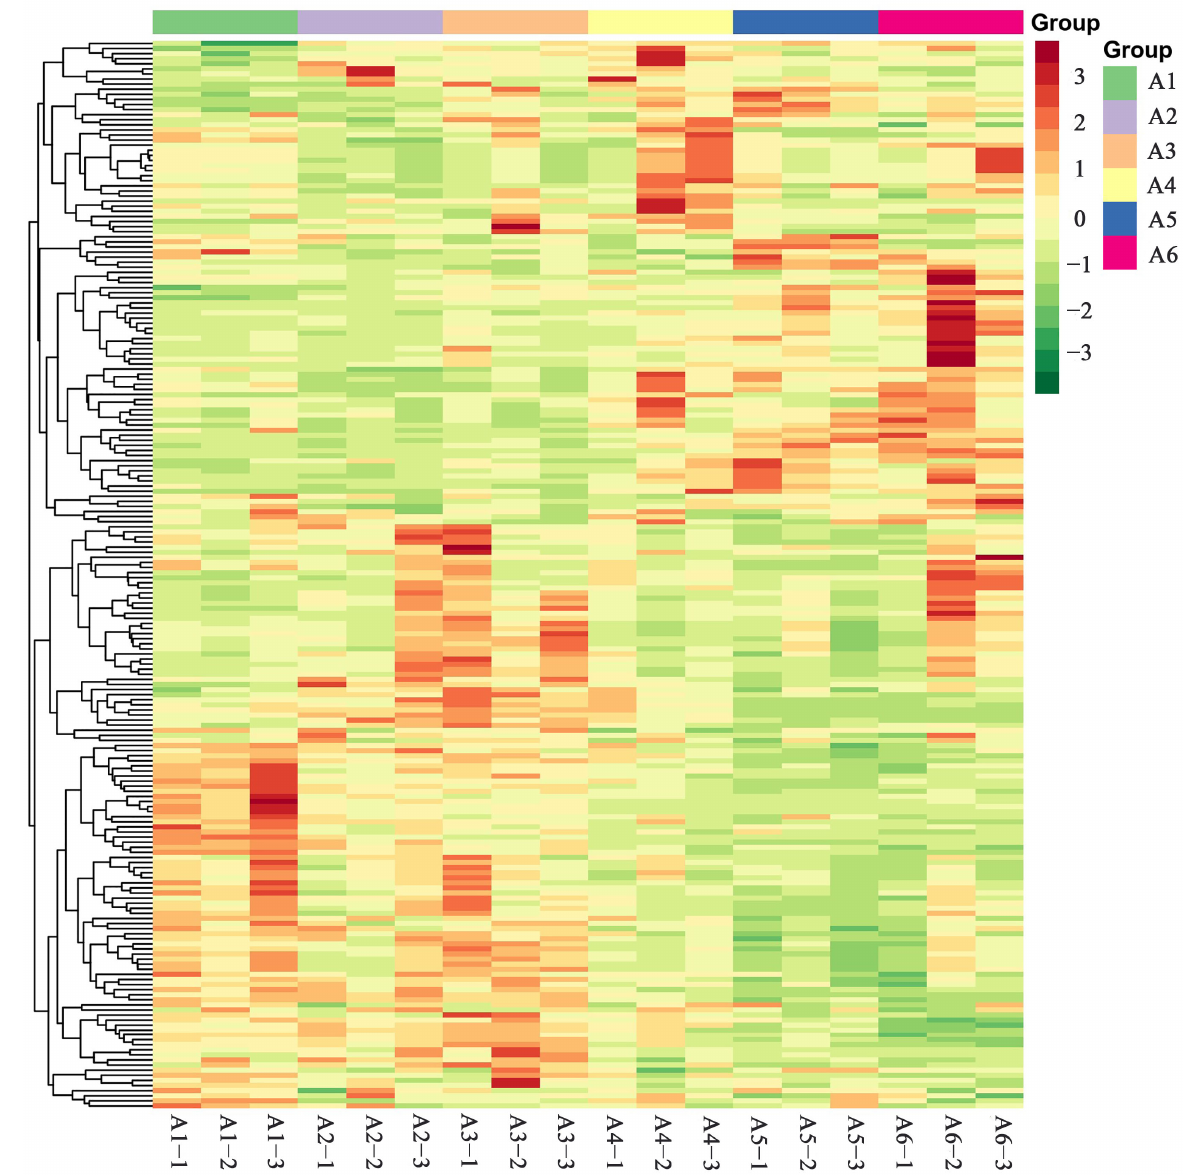
Figure 4. Heat map of cluster analysis of flavonoids in PCR at different harvest times. The abscissa represents the sample name and the ordinate represents the detected flavonoid metabolites. The order of color from orange to green indicates that the metabolite content gradually decreases.